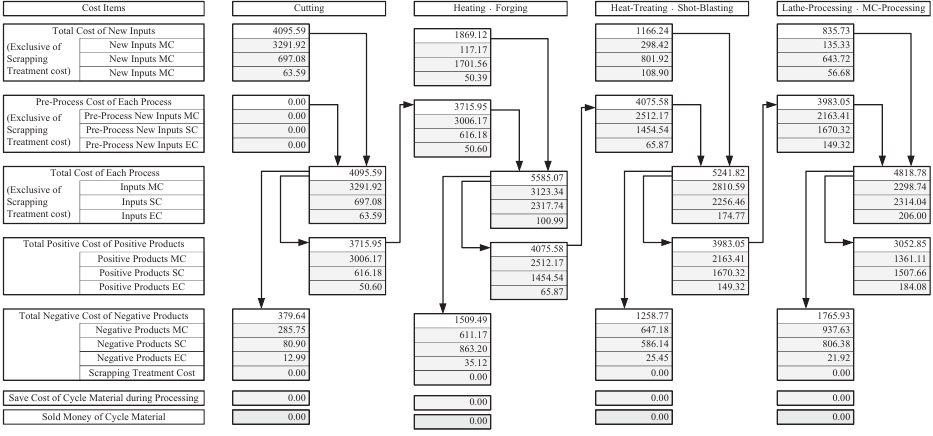
Fig. 9. MFCA flowchart including calculation data (cid:708) M 1 -Lot Size=12 (cid:709) (Unit/JPY (cid:798)